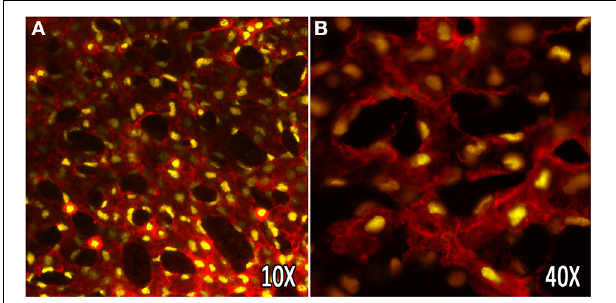
FIGURE 2 | In vivo labeling of the yolk sac vasculature using vital fluorescent reporters. The embryonic yolk sac vasculature of transgenic mice, labeling the membrane (Flk1-myr::mCherry), and nuclei (Flk1-H2B::YFP) of endothelial cells. (A,B) Vascular plexus of the embryonic yolk sac at E8.5 at 10 × and 40 × (oil) magnification,